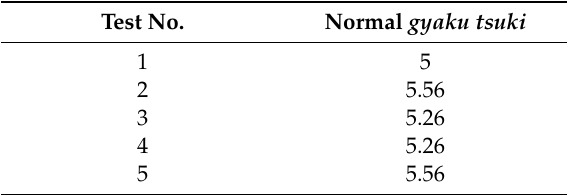
Table 2. Maximum attainable speeds (ms − 1 ) of the punches. Test